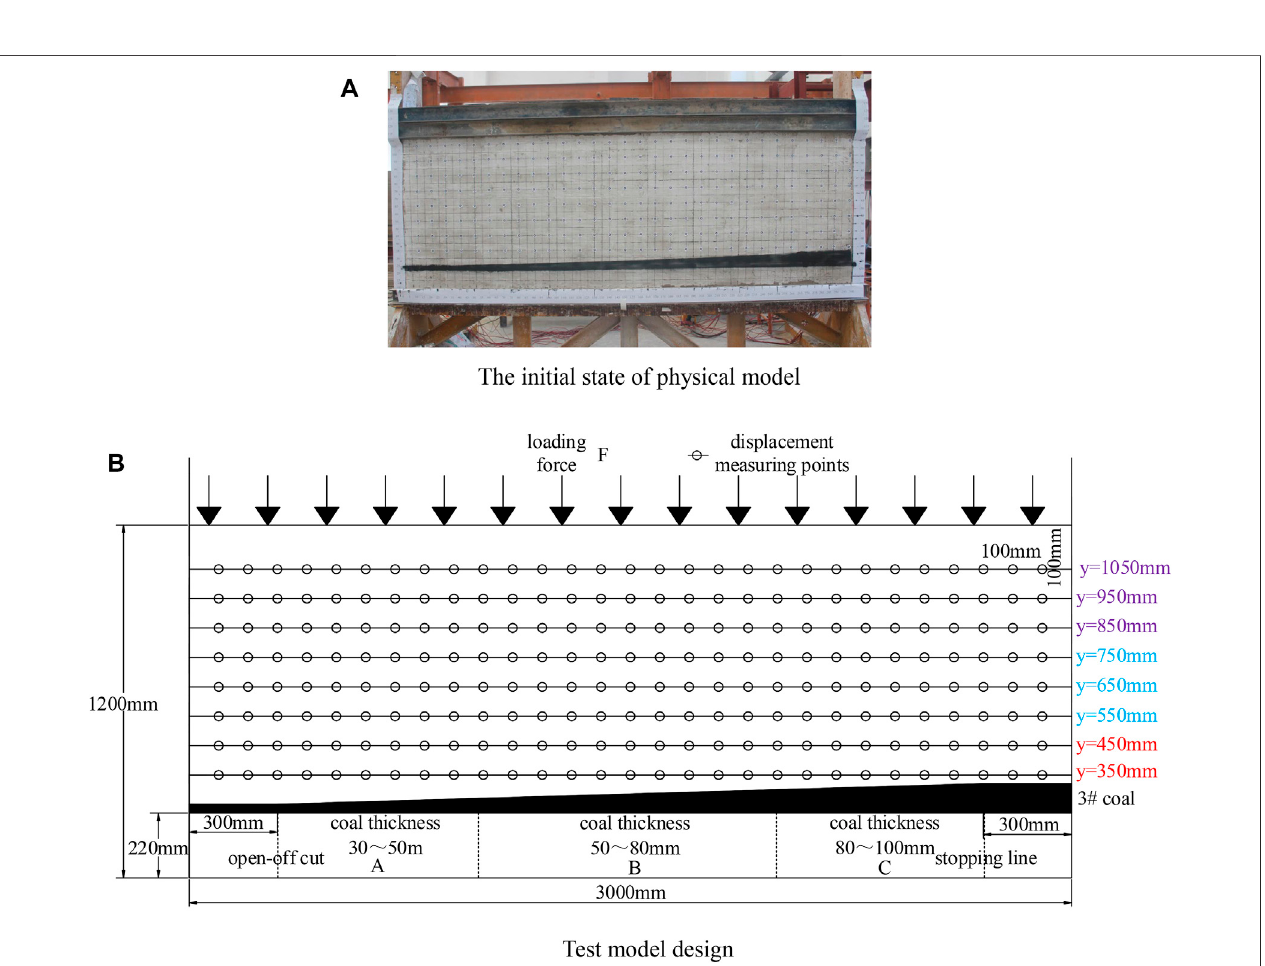
FIGURE 6 | Model of physical simulation test. (A) The initial state of physical model; (B) Test model design.